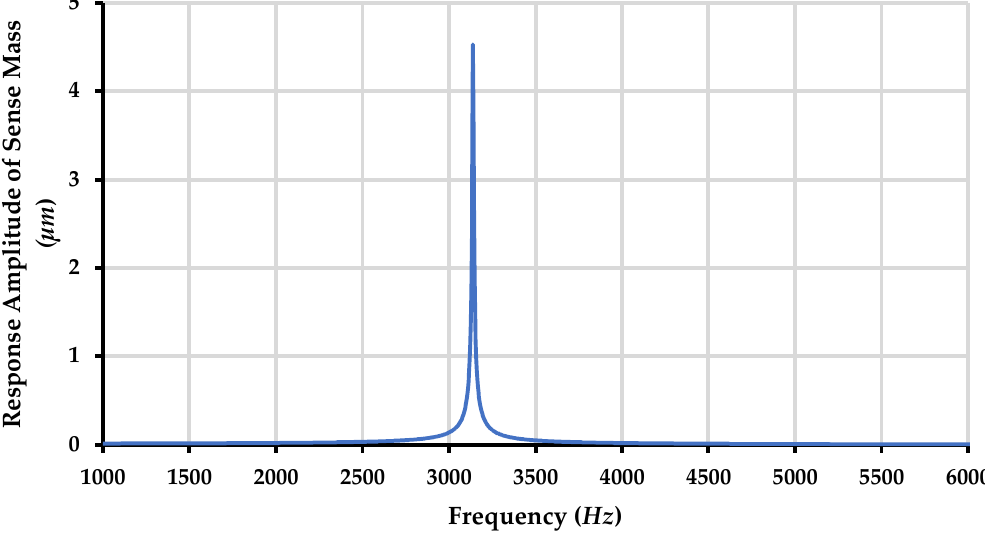
Figure 21. Response amplitude of the sense mass m 3 of the proposed MEMS gyroscope for vacuum conditions.